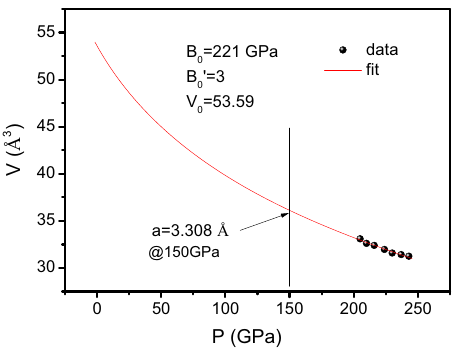
Fig. 5 The structure characterizations. The pressure dependence of unit cell volume of the CaH 6 . The red line is the fi t to equation of